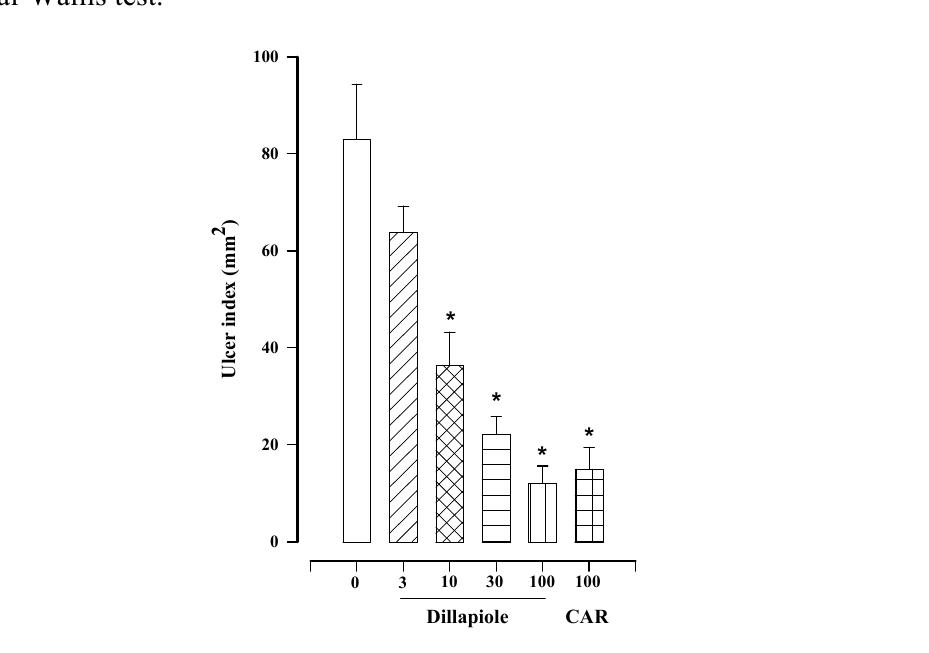
Figure 2. Effect of different doses of dillapiole (3–100 mg/kg) and carbenoxolone (CAR; 100 mg/kg) on gastric lesions induced in rats by absolute ethanol. Bars represent the mean ± SEM (n = 8). * p < 0.05 vs. the respective control; Dunn’s multiple comparison test after the Kruskal-Wallis